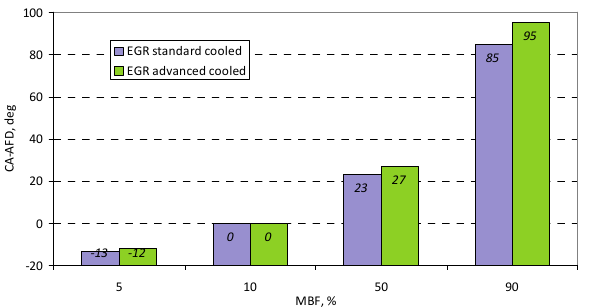
Fig. 26. Impact of EGR cooling system at CA –AFD of MBF specific value (engine rotational speed: 1400 rpm, load: 190 Nm load)